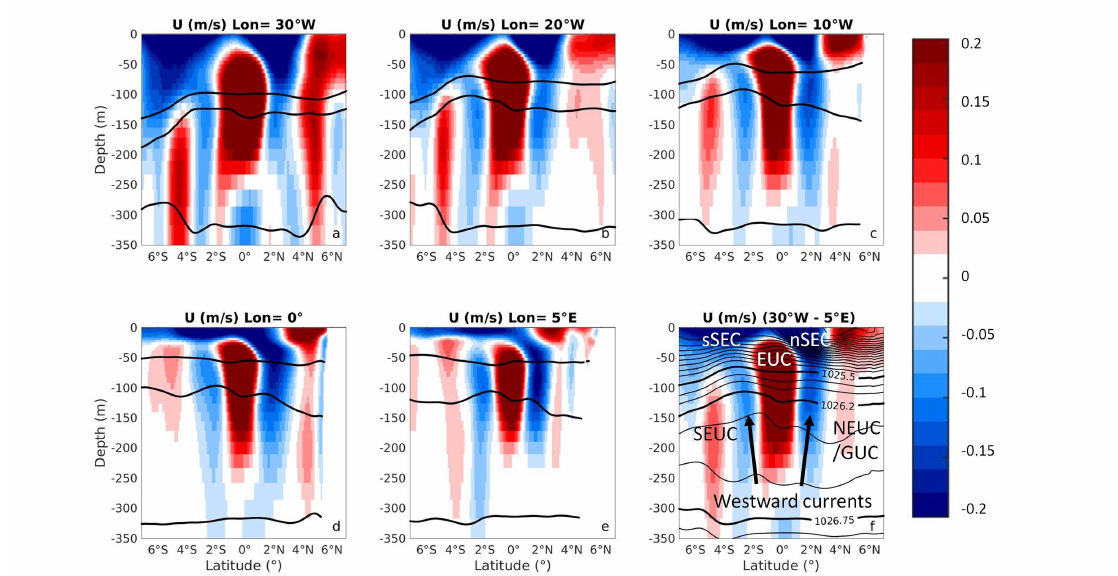
Figure 1. Meridional sections of the zonal velocity U averaged over 2015 at longitudes 30 ◦ W, 20 ◦ W, 10 ◦ W, 0 ◦ , and 5 ◦ E ( a – e ) and zonal mean (30 ◦ W to 5 ◦ E) of the temporal averaged ( f ). Thick black lines are associated with the position of isopycnic surfaces with potential density ρ = 1025.5, 1026.2 and 1026.75 kg · m − 3 defining layers 1 and 2. Thin black lines on the zonal mean are additional density contours (step ∆ ρ = 0.2 kg · m − 3 ).